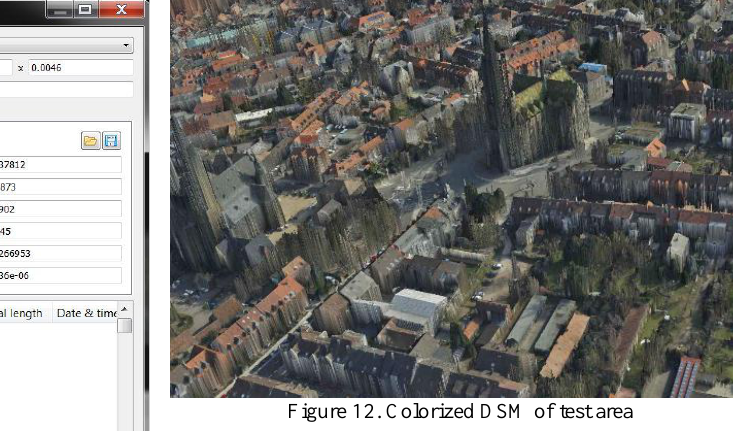
Figure 12. Colorized DSM of test